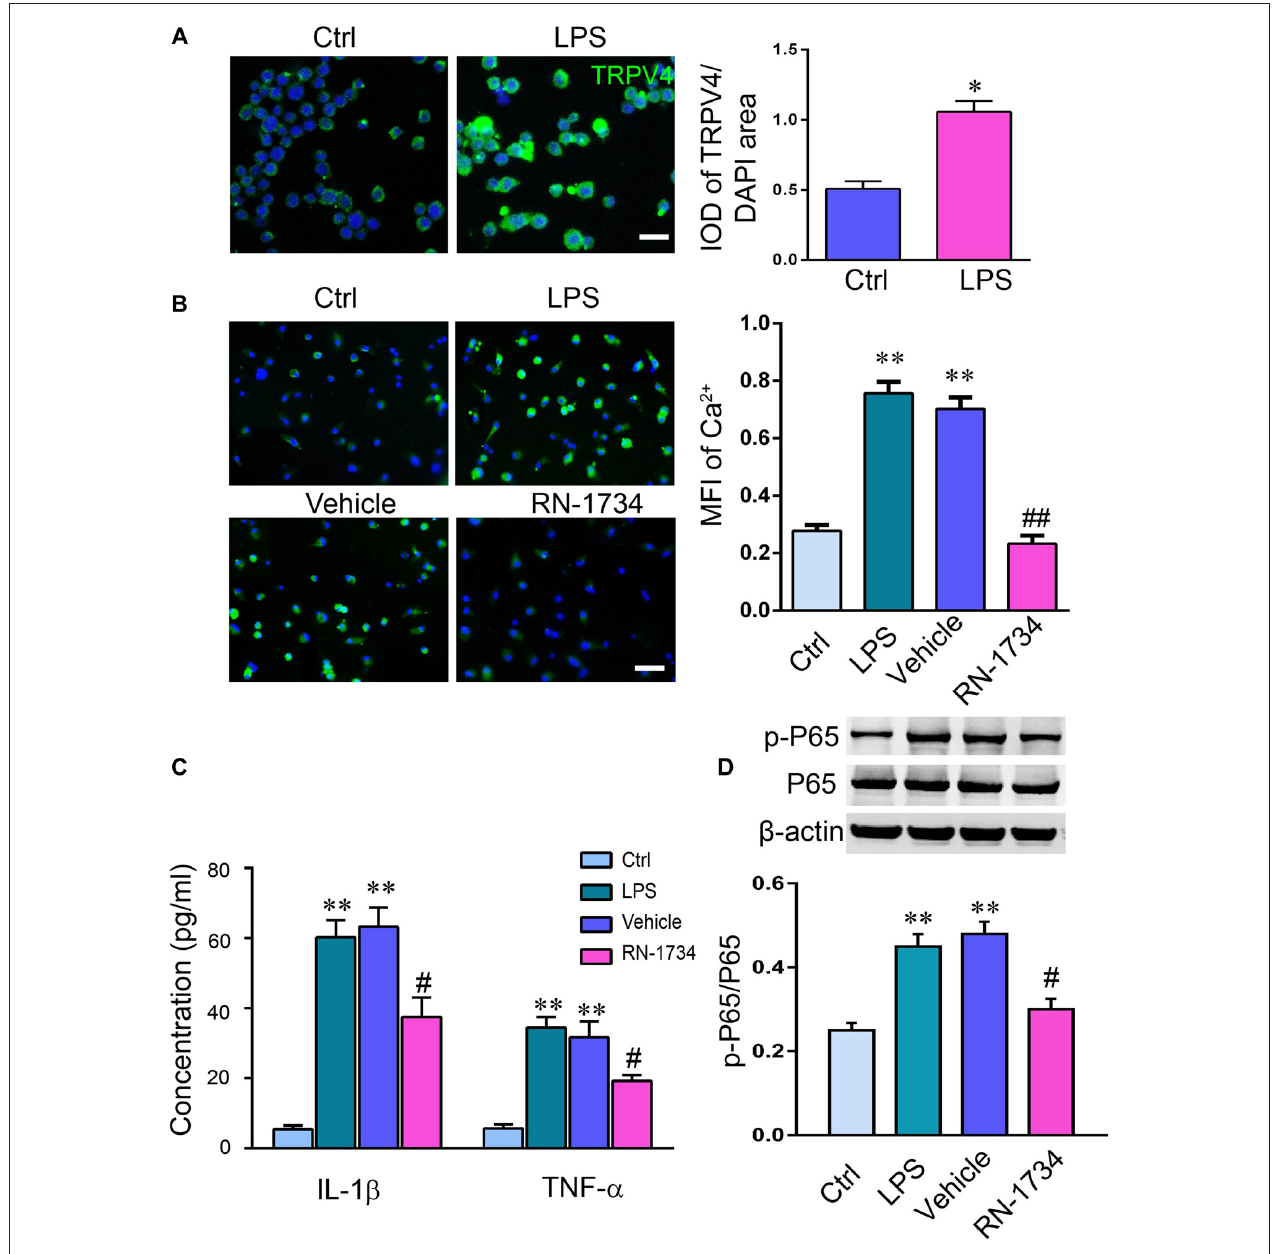
FIGURE 4 | TRPV4 activation increased the release of proinflammatory cytokines by activating the NF- κ B signaling pathway. (A,B) Lipopolysaccharide (LPS) increased the IOD of TRPV4-positive microglial cells. (C) The level of intracellular Ca 2 + in microglia was measured with Rhod-2 AM. The mean fluorescence intensity (MFI) of Ca 2 + was elevated by LPS stimulation, and RN-1734 treatment reversed the increase in the MFI of Ca 2 + . (D) The concentration of TNF- α and IL-1 β detected by ELISA in the Ctrl, CPZ, vehicle and RN-1734 groups. n = 5 per group. The data are expressed as the mean ± SEM. ∗ P < 0.05, ∗∗ P < 0.01 vs. the Ctrl group; # P < 0.05, ## P < 0.01 vs. the vehicle